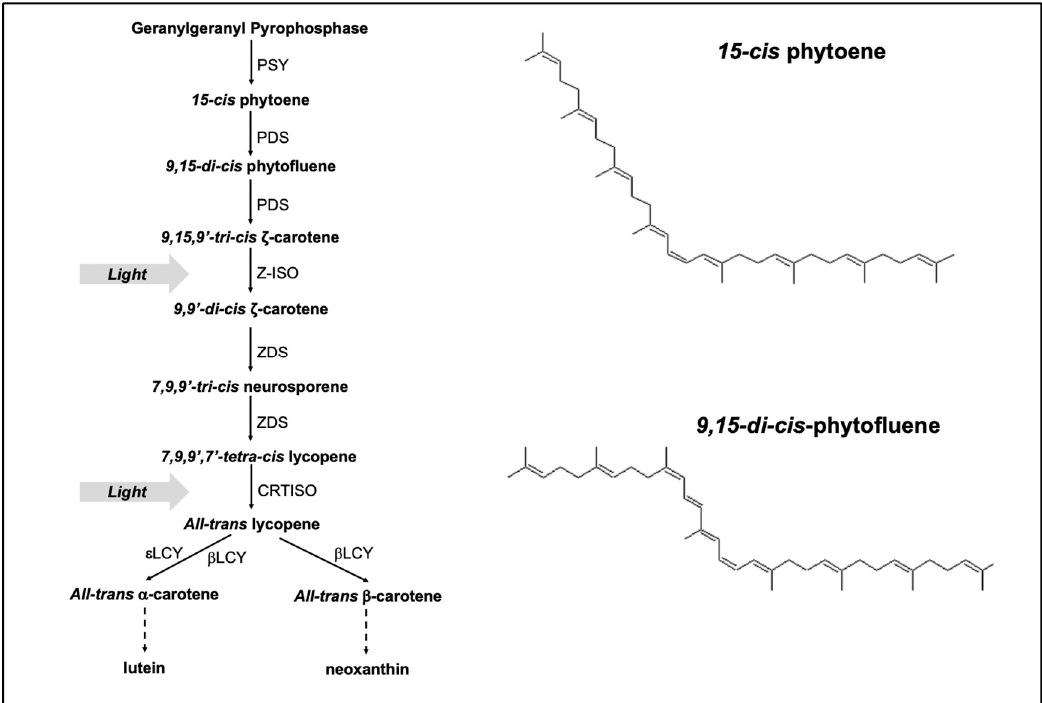
Figure 1. A generally acknowledged biosynthetic pathway of carotenoids in plants and algae [8,9,10]. PSY, phytoene synthase; PDS, phytoene desaturase; Z- ISO, ζ - carotene isomerase; ZDS, ζ -carotene de-